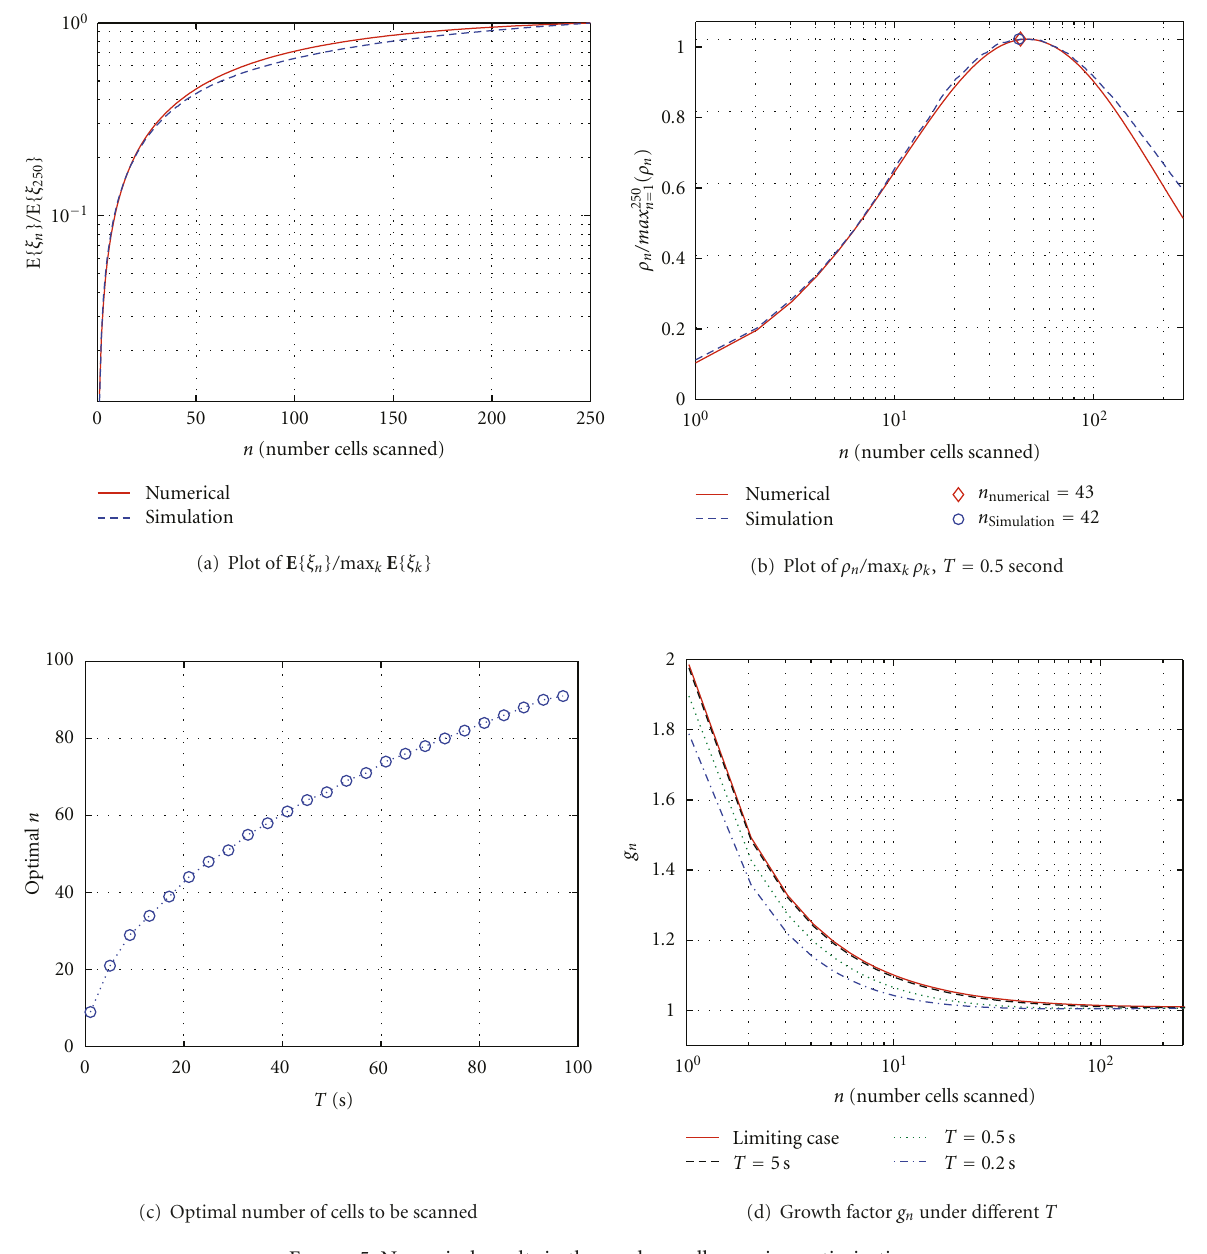
Figure 5: Numerical results in the random cell scanning